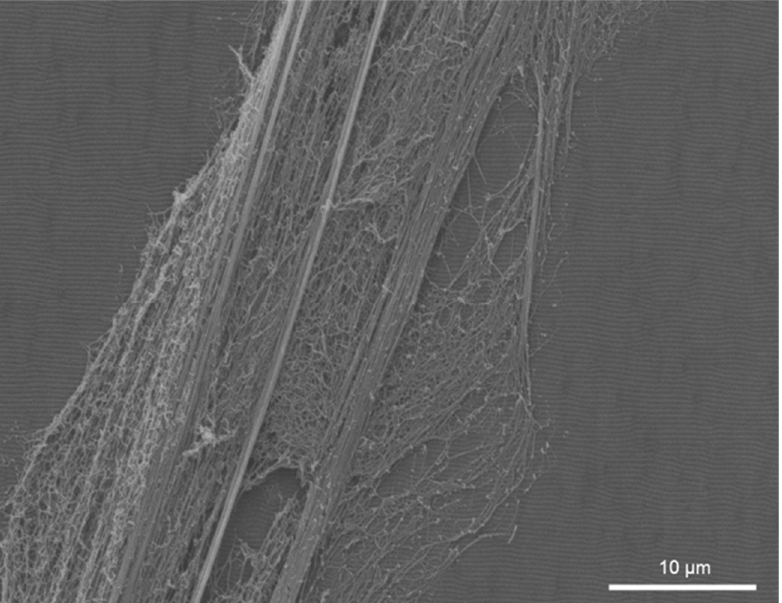
Figure 6. SEM image of nanofibers on a biomimetic polymer foil, gold-sputtered after interaction. A cribellate capture thread with its nanofibers lies perpendicular to the LIPSS. These prevent the thread from smoothly adapting to the surface and thus reduce adhesion.